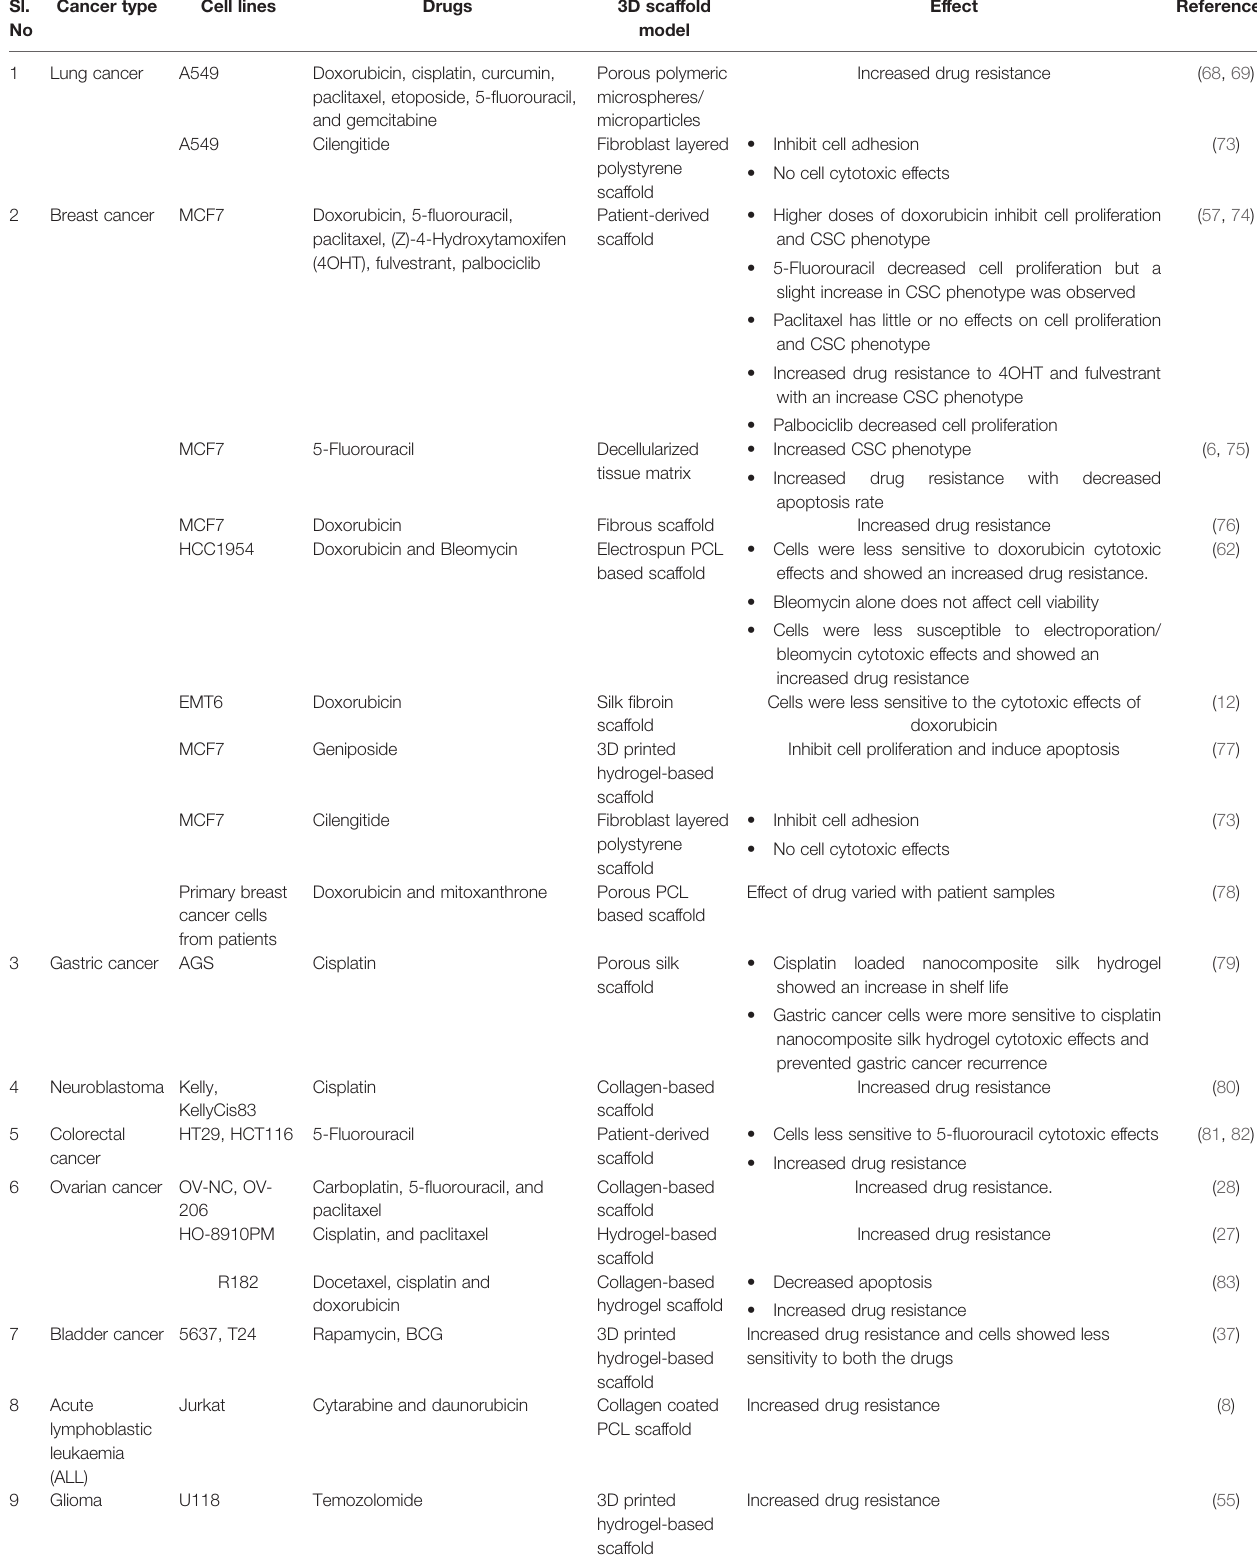
TABLE 3 | Anti-cancer drugs screened using 3D tissue-engineered models in different cancer types. Sl. Cancer No